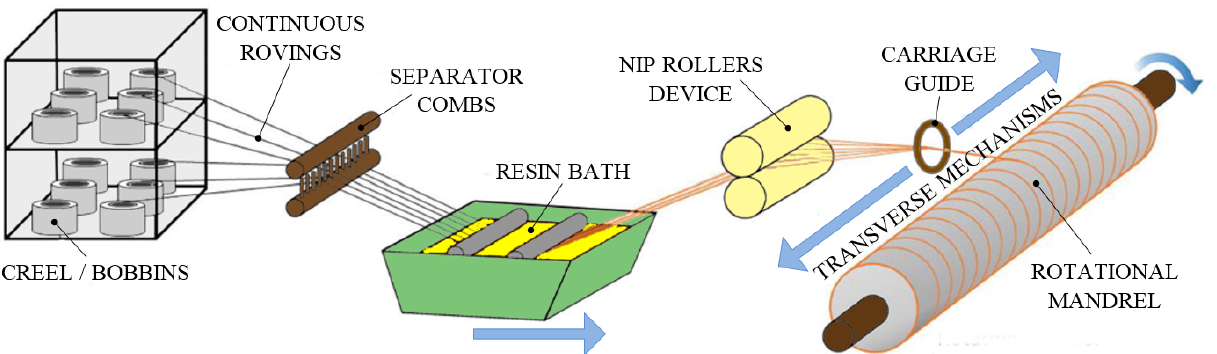
Figure 12. Schematic diagram of a typical filament winding process.